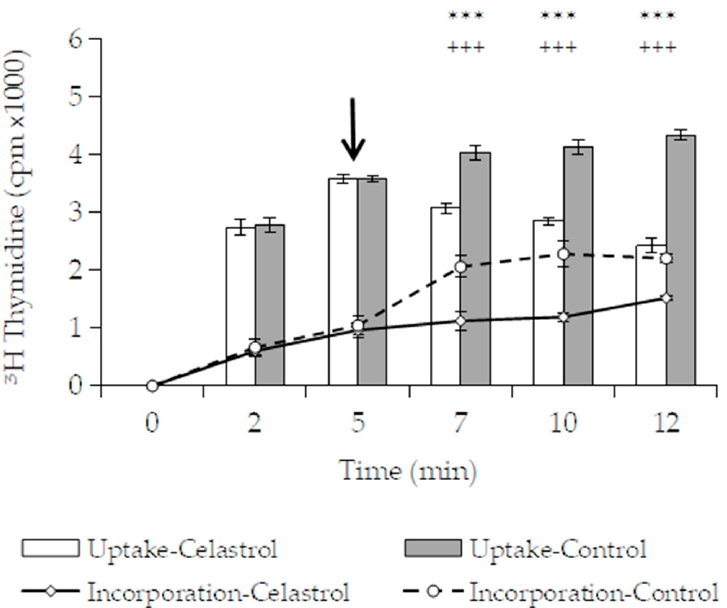
Figure 6. Incorporation (insoluble phase) and uptake (soluble phase) of radiolabeled 3 H-thymidine on B. subtilis . Bacterial culture were pretreated with ciprofloxacin (1.25 µ g/mL), a specific inhibitors of DNA biosynthesis before the addition of the radiolabeled precursor (time 0). The triterpene celastrol (3 µ g/mL), or the same proportion of DMSO used as control, was added at the time indicated by the arrow. Error bars express SD with n = 3. Significant differences found in uptake (***: p < 0.001) or incorporation (+++: p < 0.001) compared with control (one-way ANOVA; Tukey’s test).